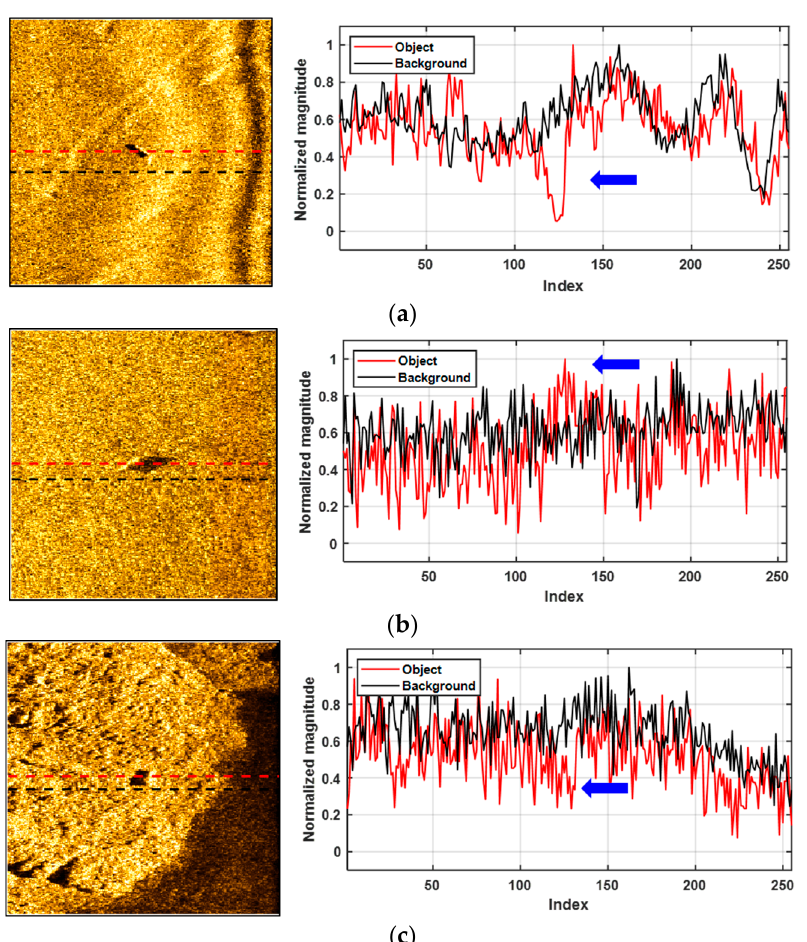
Figure 7. Sonar images and traces of the selected line; the backgrounds of the images are ( a ) mud, ( b ) sand, and ( c ) rock. The red line indicates the object signals (blue arrow), and the black line represents an arbitrary background signal.